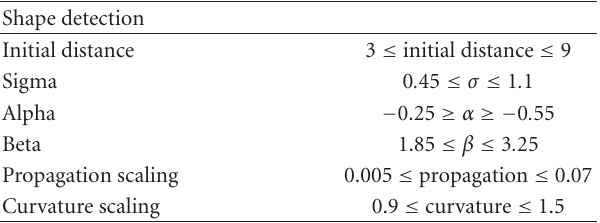
Table 3: Internal constraints for shape detection level sets.